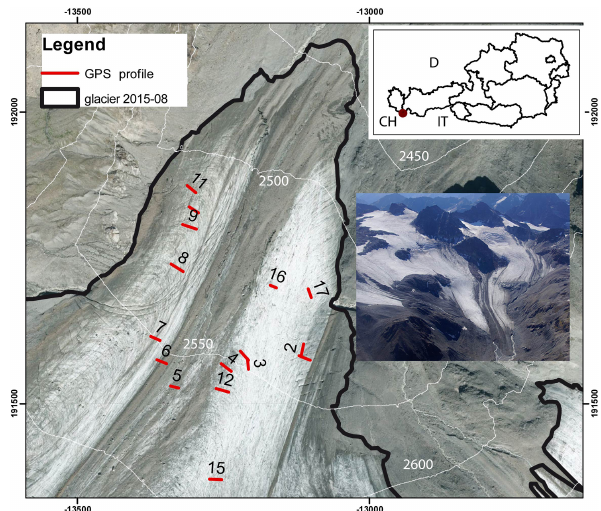
Figure 1. Glacier tongue of Jamtalferner (Orthophoto, August 2015, Source: Tyrolean Government/TIRIS) with profile lines of spectroradiometer measurements indicated in red. Insert: aerial pho- tograph of Jamtalferner, 20 September 2018 (Photo: Andrea Fis-